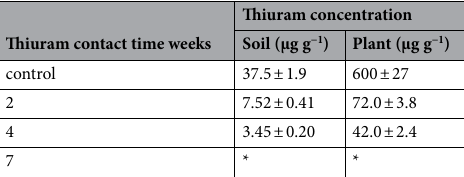
Table 2. Thiuram concentration in soil and dandelion plant over contact time (mean ± SE, n = 5). *Below the detection limit.